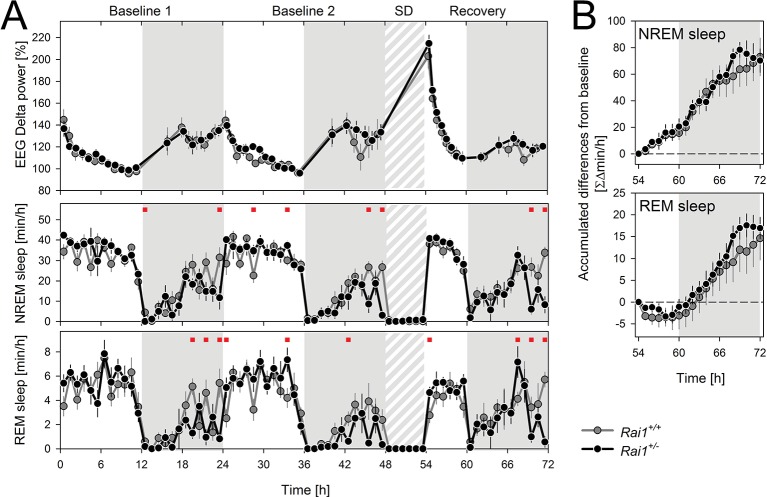
Sleep homeostasis is not altered in Rai1+/- mice.(A) Average time course of EEG delta power (1–4 Hz) in NREM sleep (top), time spent in NREM sleep (middle) and in REM sleep (bottom panel) under LD12:12. After 2 baseline days (0–48 hr), animals were sleep deprived for 6 hr (48–54 hr) by gentle handling starting at light onset. Recovery was monitored over the remaining 18 hr of the 3-day recording (54–72 hr). Rai1+/+: grey lines and symbols; Rai1+/-: black lines and symbols. Red squares above data mark significant genotype differences (p<0.05; t-tests). (B) Mean hourly accumulation of differences from baseline in time spent in NREM (top) and REM (bottom panel) sleep during the 18 hr of recovery sleep after the SD (54–72 hr) did not differ between genotypes. Rai1+/- n = 7; Rai1+/+ n = 8.